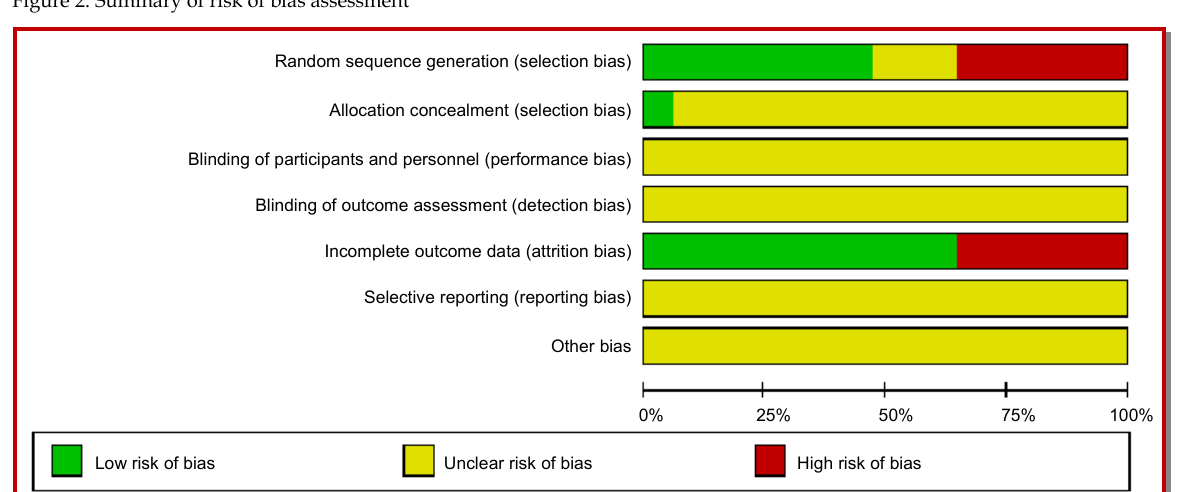
Figure 2: Summary of risk of bias assessment